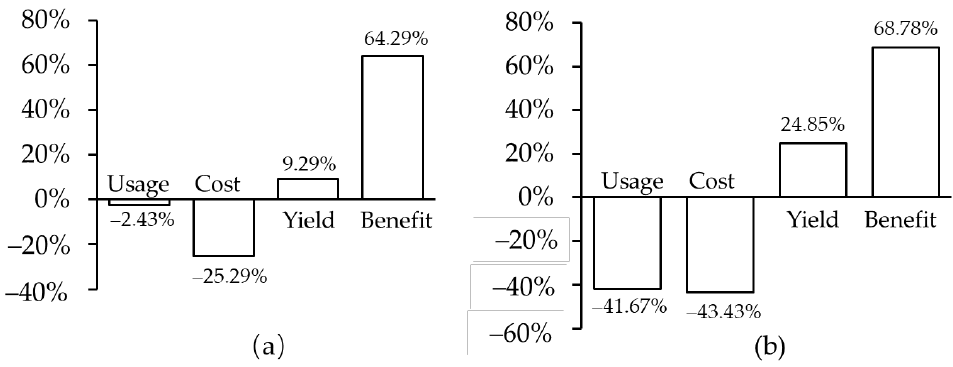
Figure 2. Benefits of herbicide-resistant ( a ) and insecticidal ( b ) transgenic crops.